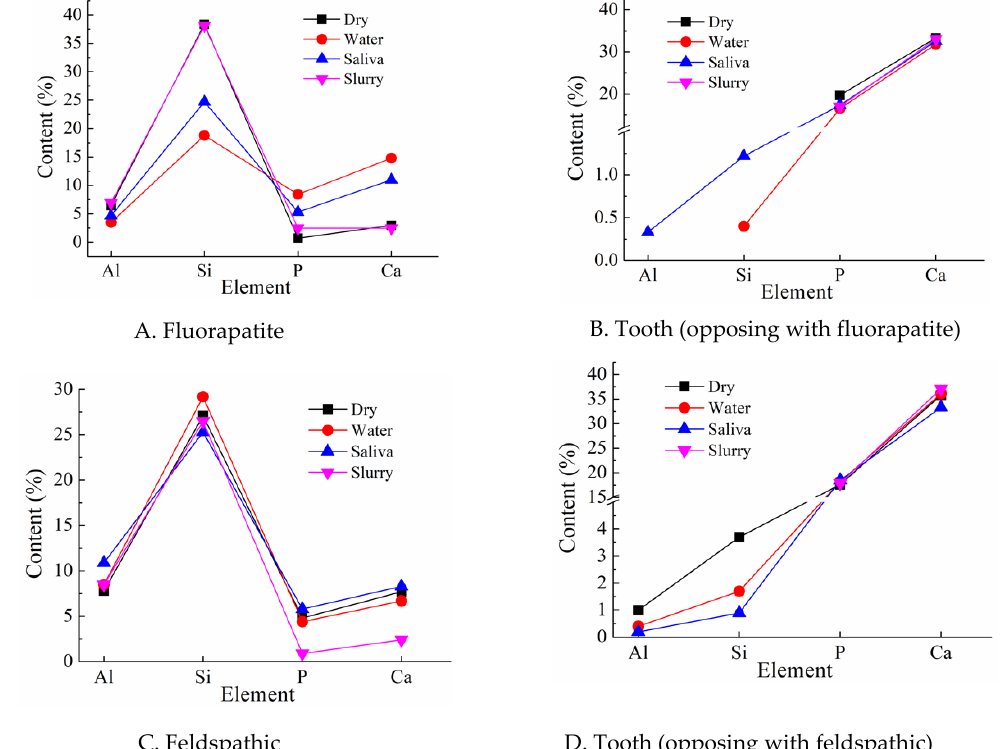
Figure 5. Contents of some elements on worn surfaces of ( a ) fluorapatite glass-ceramics and ( b ) their opposing teeth, and ( c ) feldspathic glass-ceramics and ( d ) their opposing teeth, obtained by EDX.